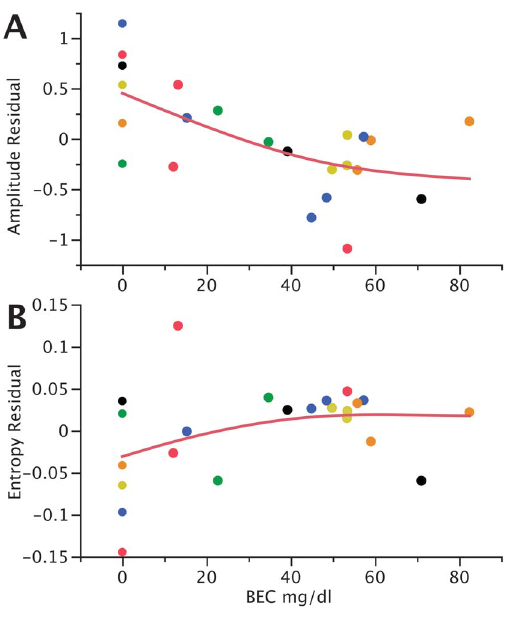
Fig. 6. Dose-relationships between BEC and motif-level (A) amplitude and (B) entropy. The vertical axis is centered on residual values calculated around individual birds, and individual birds are represented by unique colors. The traces are spline fits ( l 5